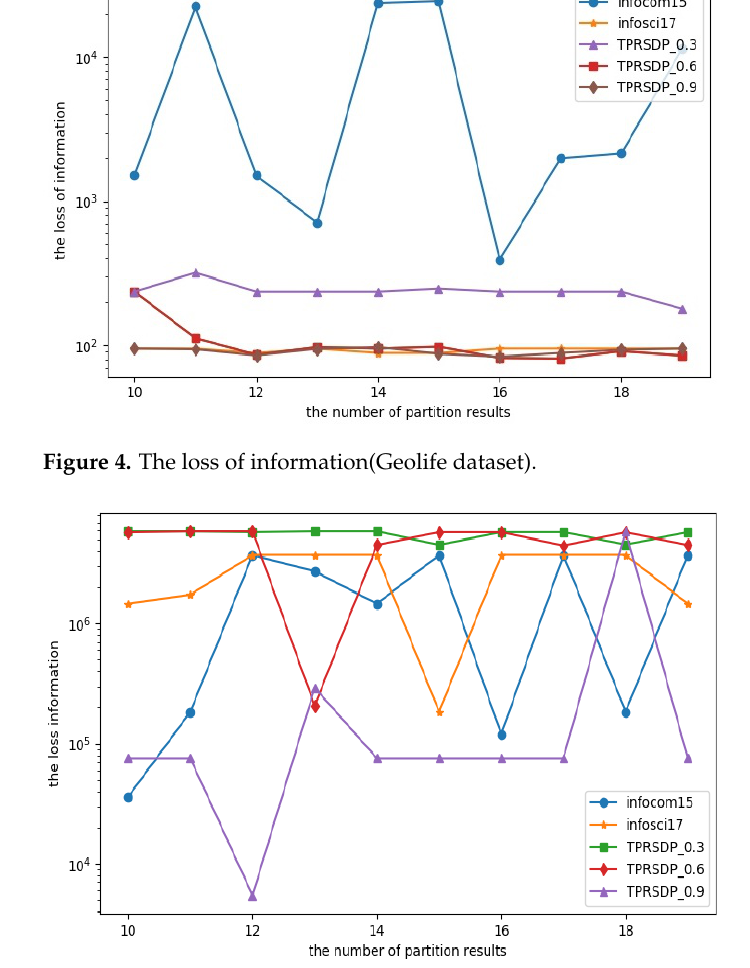
Figure 5. The loss of information(T-drive